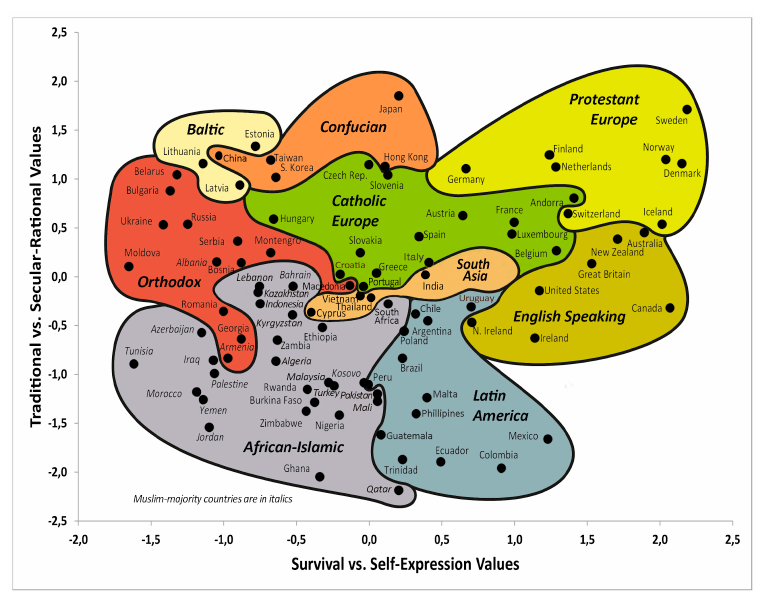
Figure 2. Most recent Cultural Map from Wave 6. Source : Inglehart and Welzel (2010).